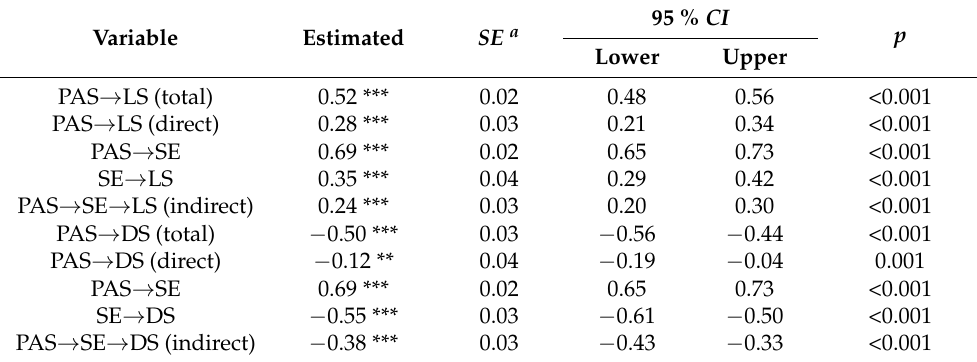
Table 4. Mediation model results for Study